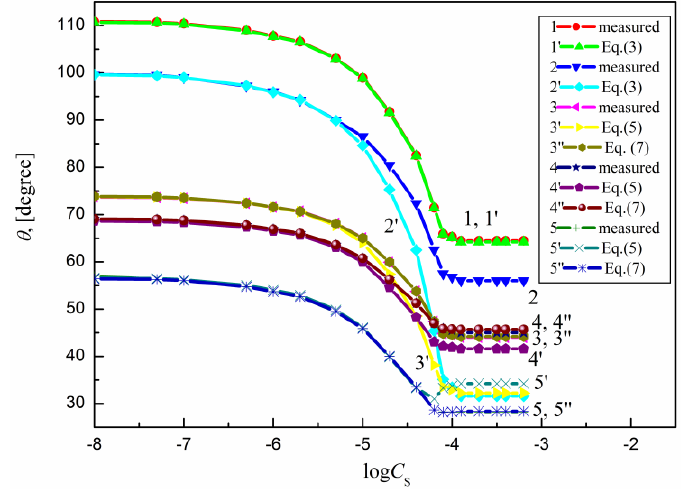
Figure 2. A plot of the contact angle ( θ ) of the aqueous solution of DDGP on the PTFE (curves 1 and 1 (cid:48) ), PE (curves 2 and 2 (cid:48) ), PMMA (curves 3, 3 (cid:48) and 3 (cid:48)(cid:48) ), nylon 6 (curves 4, 4 (cid:48) and 4 (cid:48)(cid:48) ) and quartz (curves 5, 5 (cid:48) and 5 (cid:48)(cid:48) ) against the logarithm of DDGP concentration ( C S ). Curves 1–5—the measured θ values, curves 1 (cid:48) and 2 (cid:48) —the θ values calculated from Equation (3), curves 3 (cid:48) , 4 (cid:48) and 5 (cid:48) —the θ values calculated from Equation (5) and curves 3 (cid:48)(cid:48) , 4 (cid:48)(cid:48) and 5 (cid:48)(cid:48) —the θ values calculated from Equation (7).